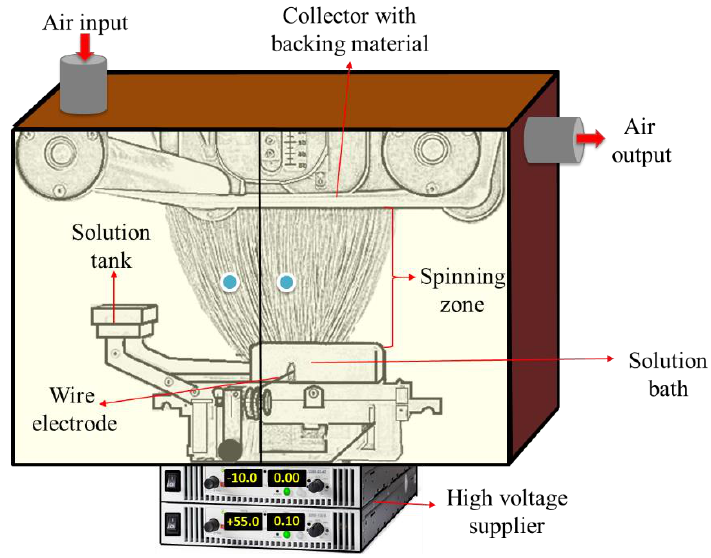
Figure 1. Schematic diagram of an electrospinning unit.